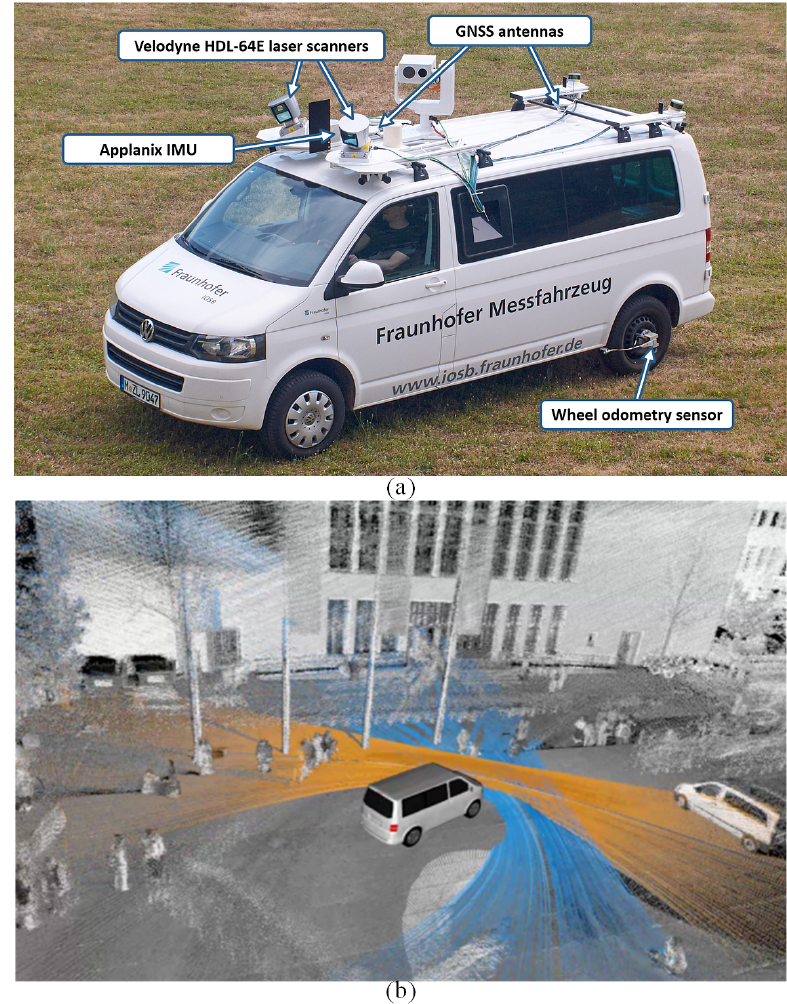
Figure 2. MLS system and its components. ( a ) MODISSA platform from Fraunhofer IOSB [20]. ( b ) Illustration of data acquisition with the two obliquely mounted laser scanners